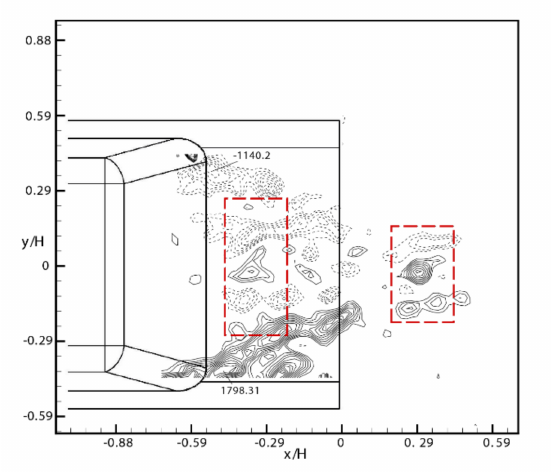
Figure 22. Iso-contours of instantaneous streamwise vorticity, ω z in x–y plane at z/H = 0.18. Minimum and incremental values of vorticity are ω z,min = − 405.572 s − 1 , 329.056 s − 1 , and − 1 , ∆ ω z = 169.530 s